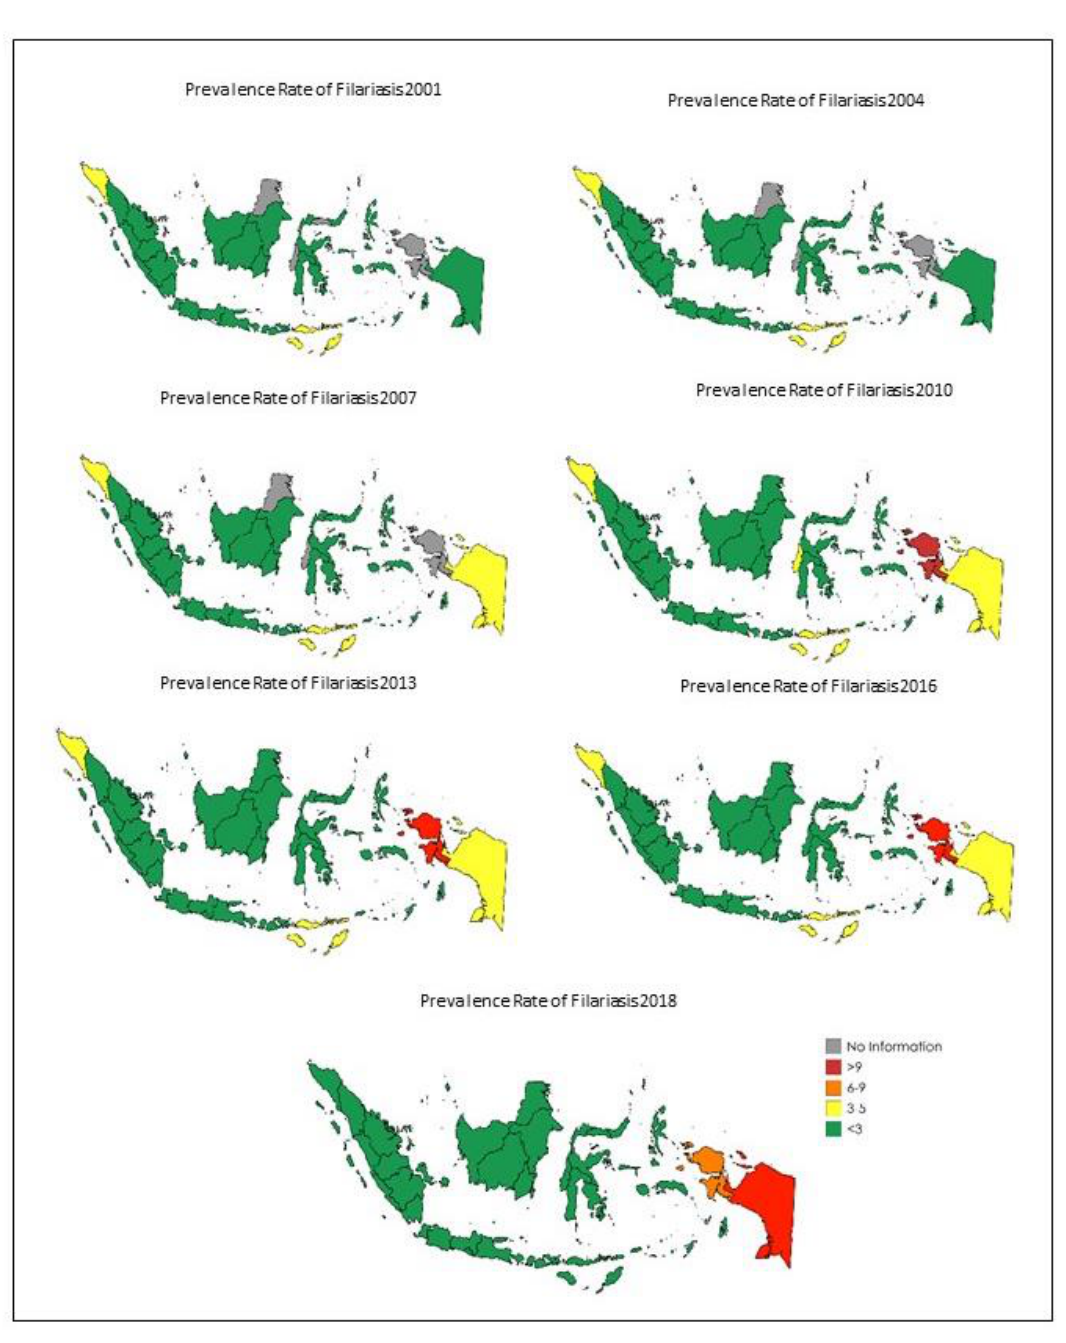
Figure 4. Distribution of Lymphatic Filariasis Prevalence Rate in Indonesia, 2001 – 2018.